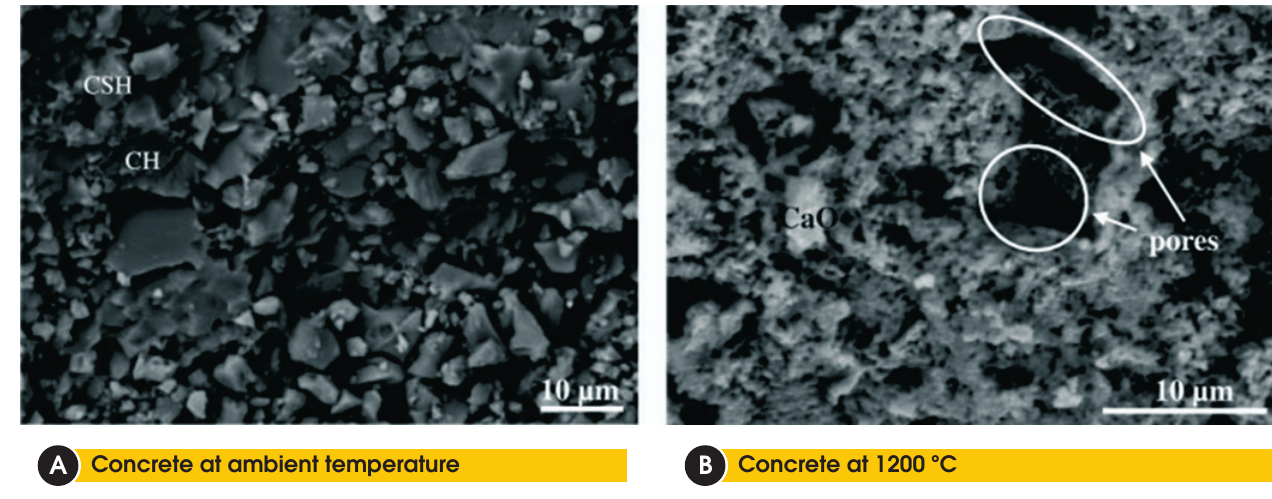
Changes in concrete subjected to 1200 ºC (adaptaed [36])